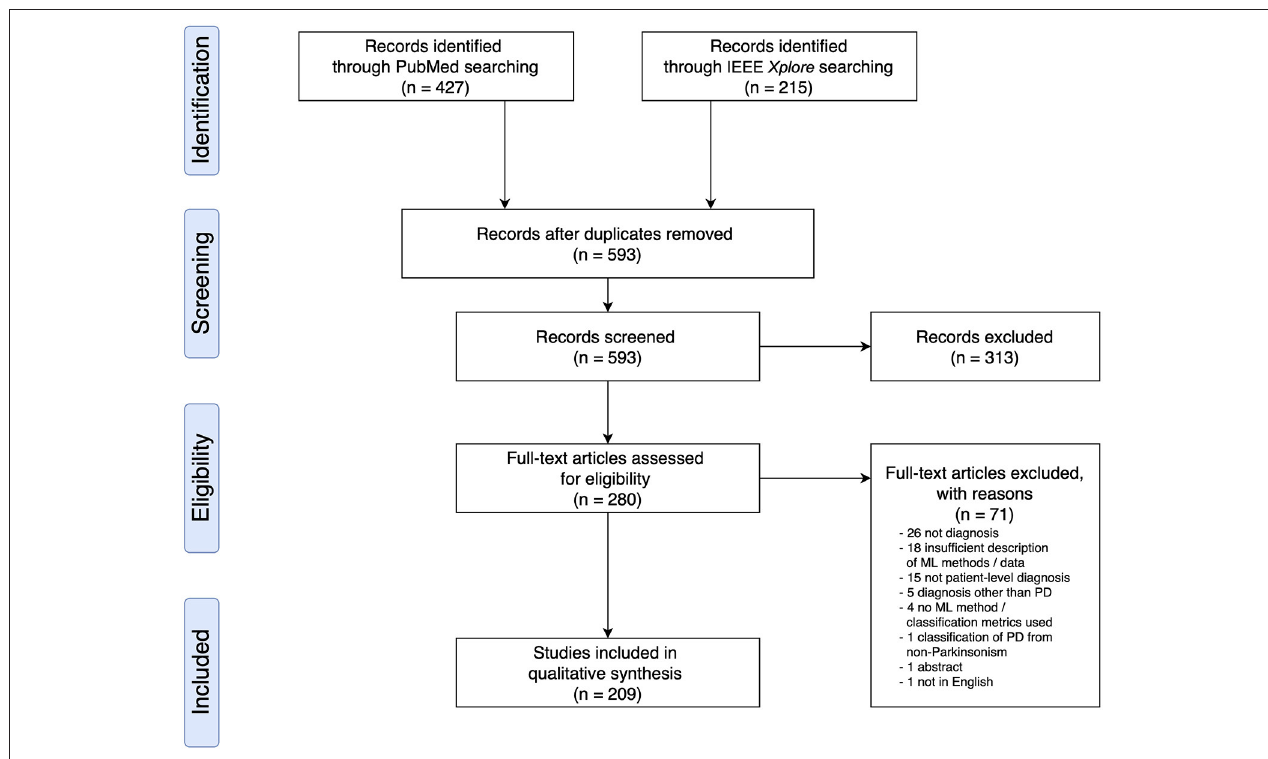
FIGURE 1 | PRISMA Flow Diagram of Literature Search and Selection Process showing the number of studies identified, screened, extracted, and included in the